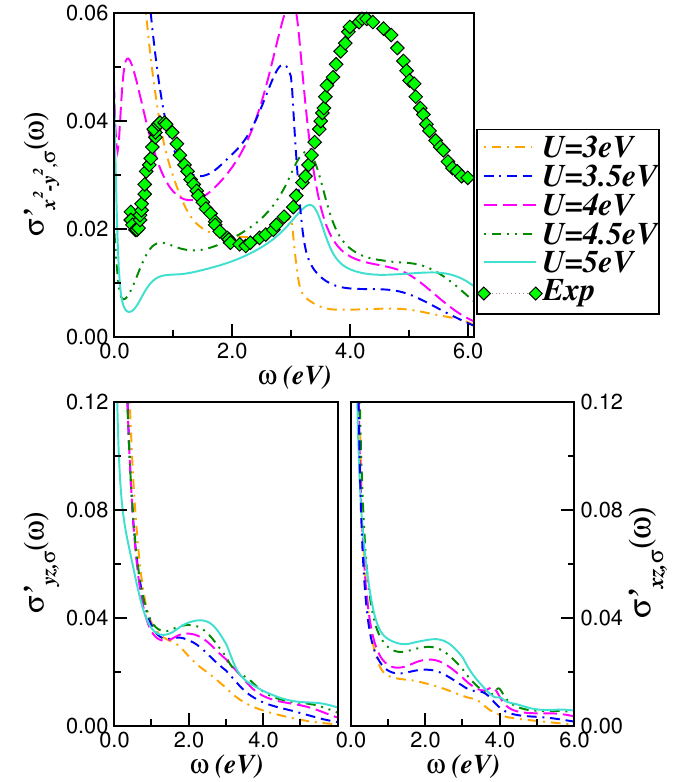
Figure 5. Orbital resolved optical conductivity of monoclinic MoO 2 computed within LDA+DMFT. Notice the changes in the Drude-like peak below 0.5 eV and its evolution with increasing U . For